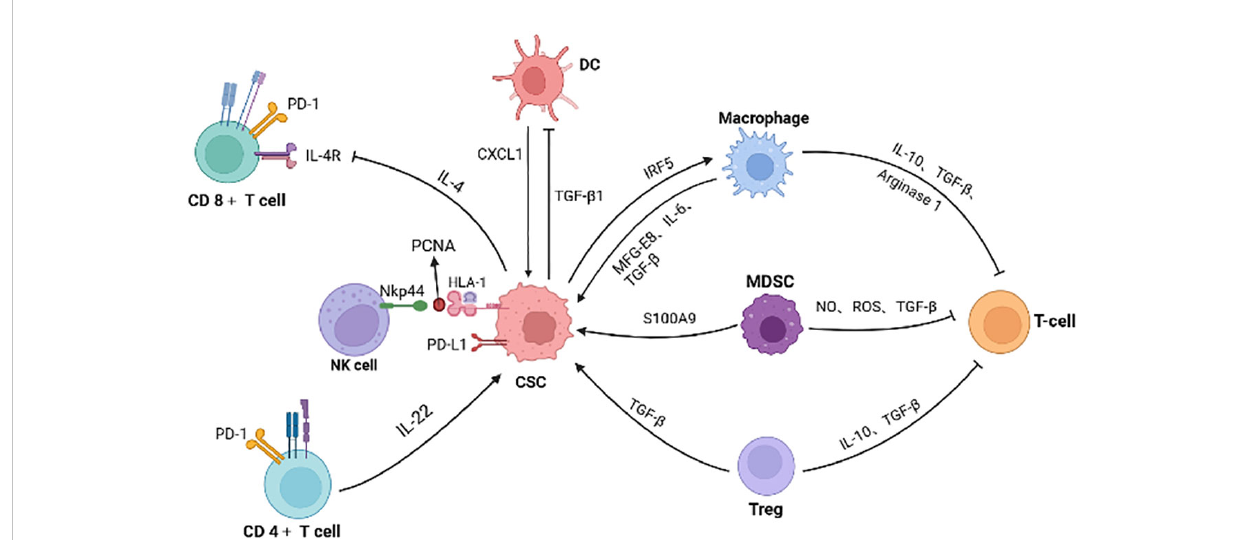
FIGURE 3 The interactions of CSC with immune cells and inhibitory effect on T cells. Immune cells (such as macrophage, MDSC, Treg and CD4 + T cells) secret factors or exosomes to promote stemness and increase the number of CSCs. CSCs also inhibit the function of immune cells. For example, colorectal CSCs secret IL-4 to inhibit T cell proliferation and TGF- b 1 to reduce the antigens presentation of DC cells. PCNA and HLA-I interactions on the surface of CSCs is identi fi ed as an inhibitory ligand for NKp44 on NK cells, thus preventing cytotoxic activation. Meanwhile, immunosuppressive cells in the microenvironment inhibit T cells, promoting the immune escape of CSCs. (Created in